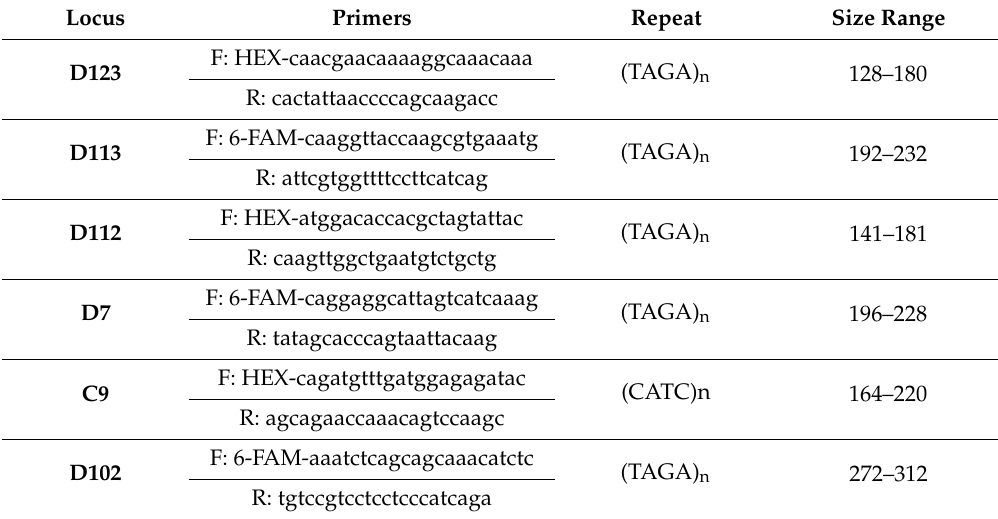
Table 1. Microsatellite primer information.